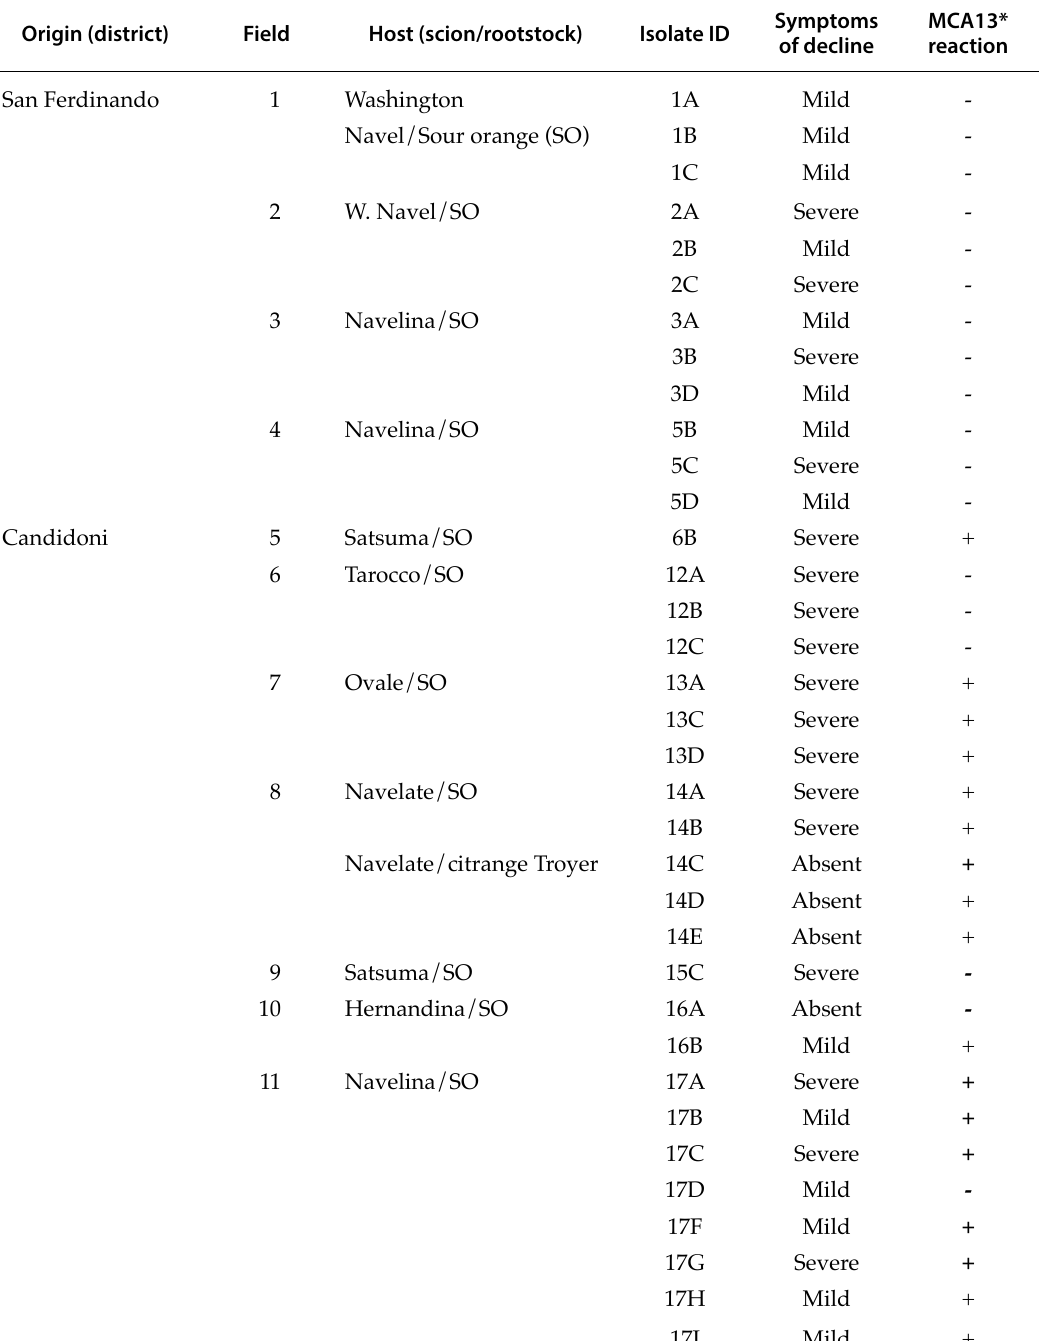
Table 1. Citrus tristeza virus isolates detected in two districts of Reggio Calabria province (Italy) from symptomatic or symp- tomless trees and their serological characterization by ELISA using the monoclonal antibody